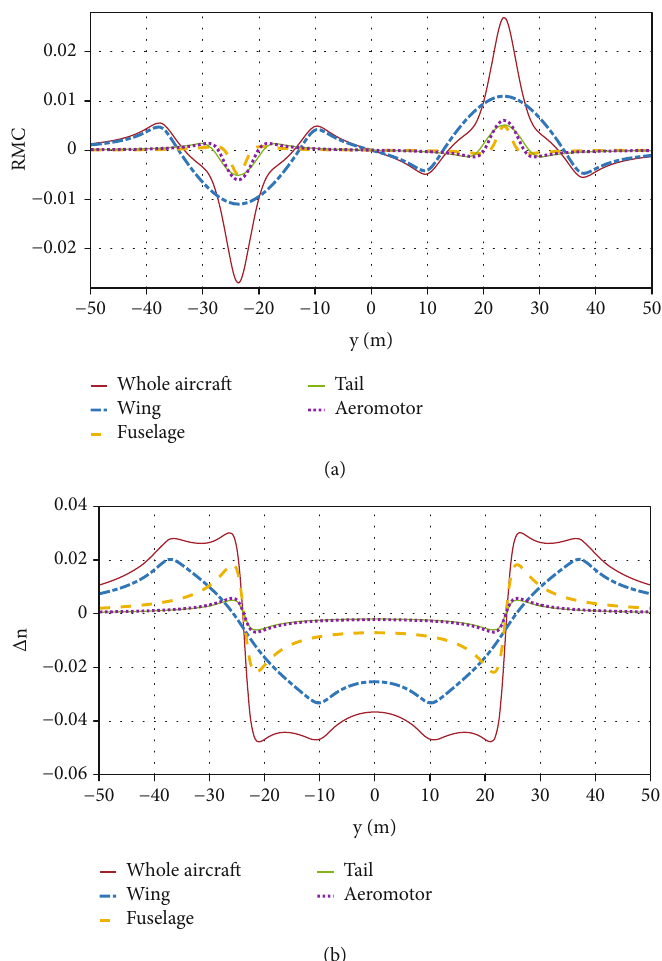
Figure 14: The coe ffi cient of each part of the ARJ21 at di ff erent spanwise positions of the wake vortex fi eld at the same